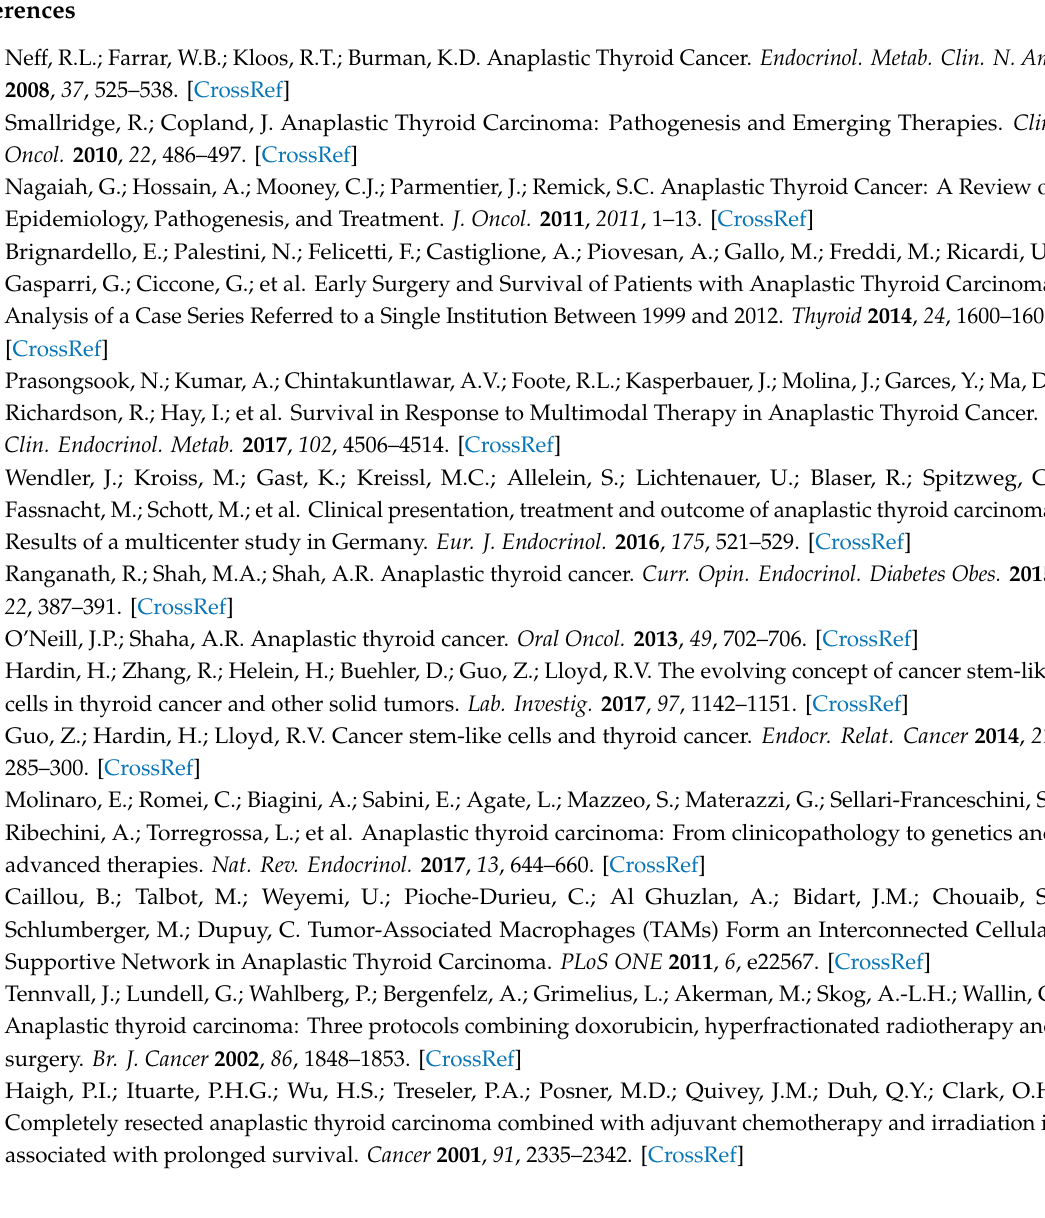
Table S1: Reported follow-up, loss to follow-up, and treatment discontinuation in the included